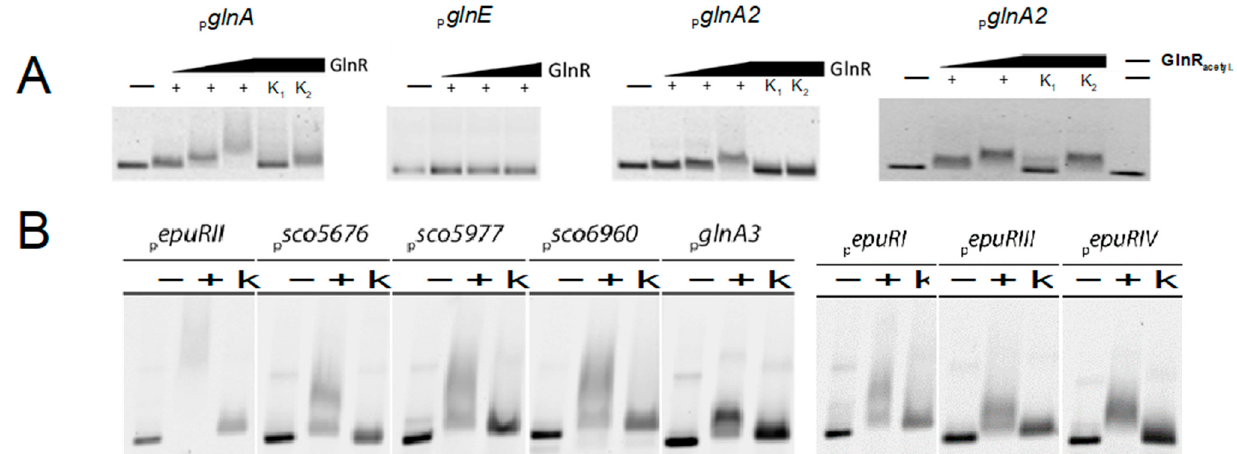
Figure 8. Band shift assays performed with GlnR and EpuRII. ( A ) 1 ng fluorescence-labeled glnA2 promoter region was incubated without ( − ) or with (+) 0.5–2 µ g Strep-GlnR (increasing arrow). As a control 1000-fold amount of unmarked specific (K1) or non-specific DNA (K2) was added. ( B ) 1 ng fluorescence-labeled promoter regions of polyamine associated genes were incubated without ( − ) or with (+) 2 µ g His-EpuRII. As a control 1000-fold amount of specific unlabeled DNA fragments (K) was added.